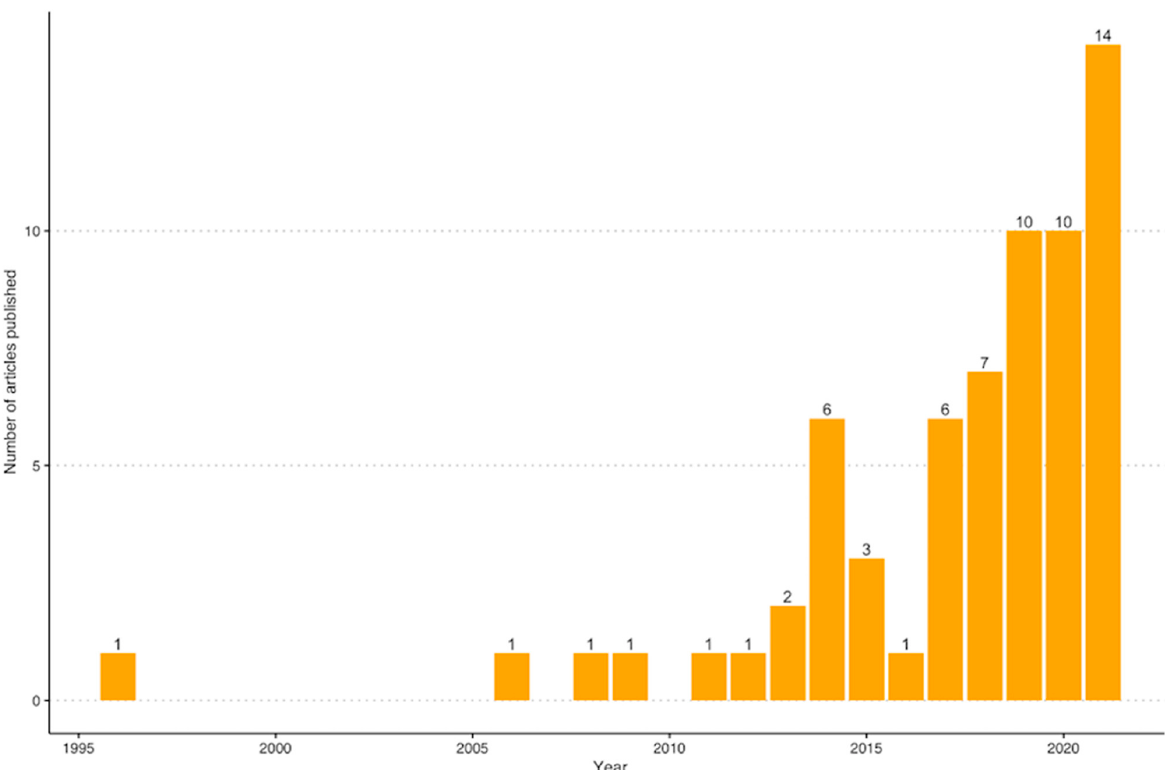
Figure 2. Number of articles relating to fast fashion and environmental and water degradation spanning published per year from 1996 to November 2021.